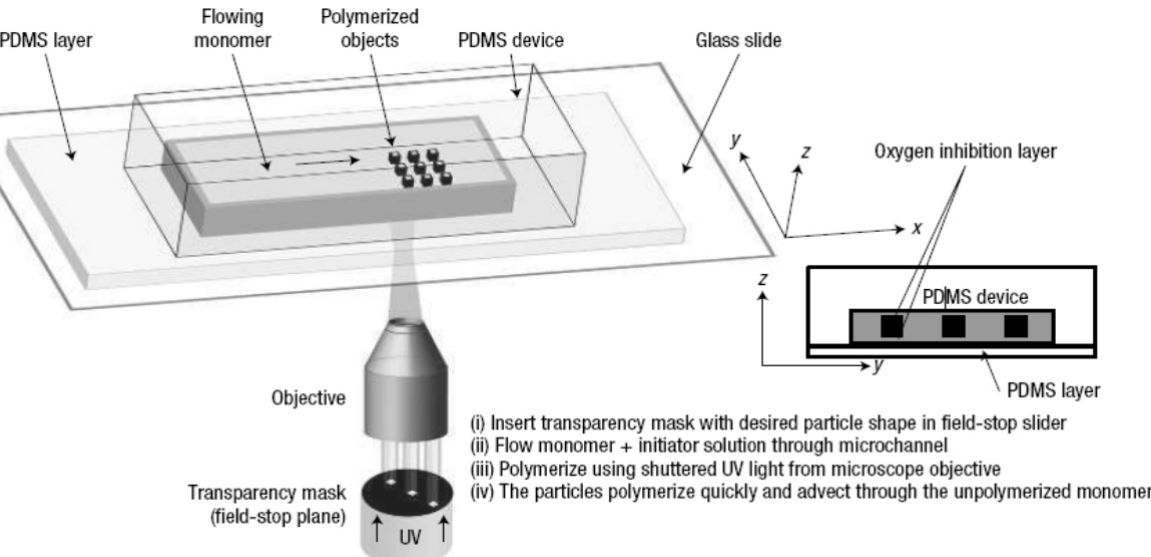
Figure 25. Schematic representation of the continuous flow projection photolithography